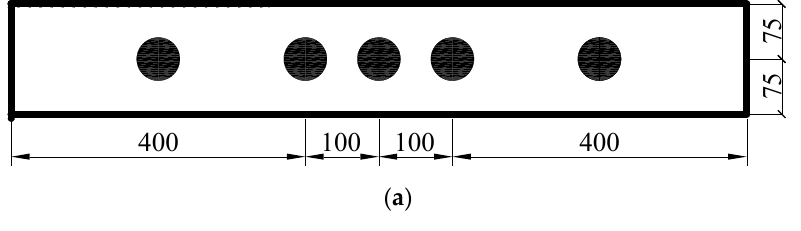
Figure 5. Specimens out of cistern.